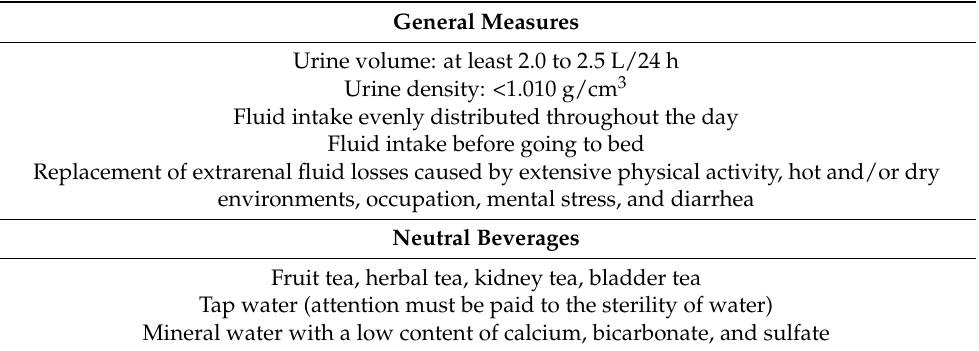
Table 1. Recommendations for fluid intake—adapted from